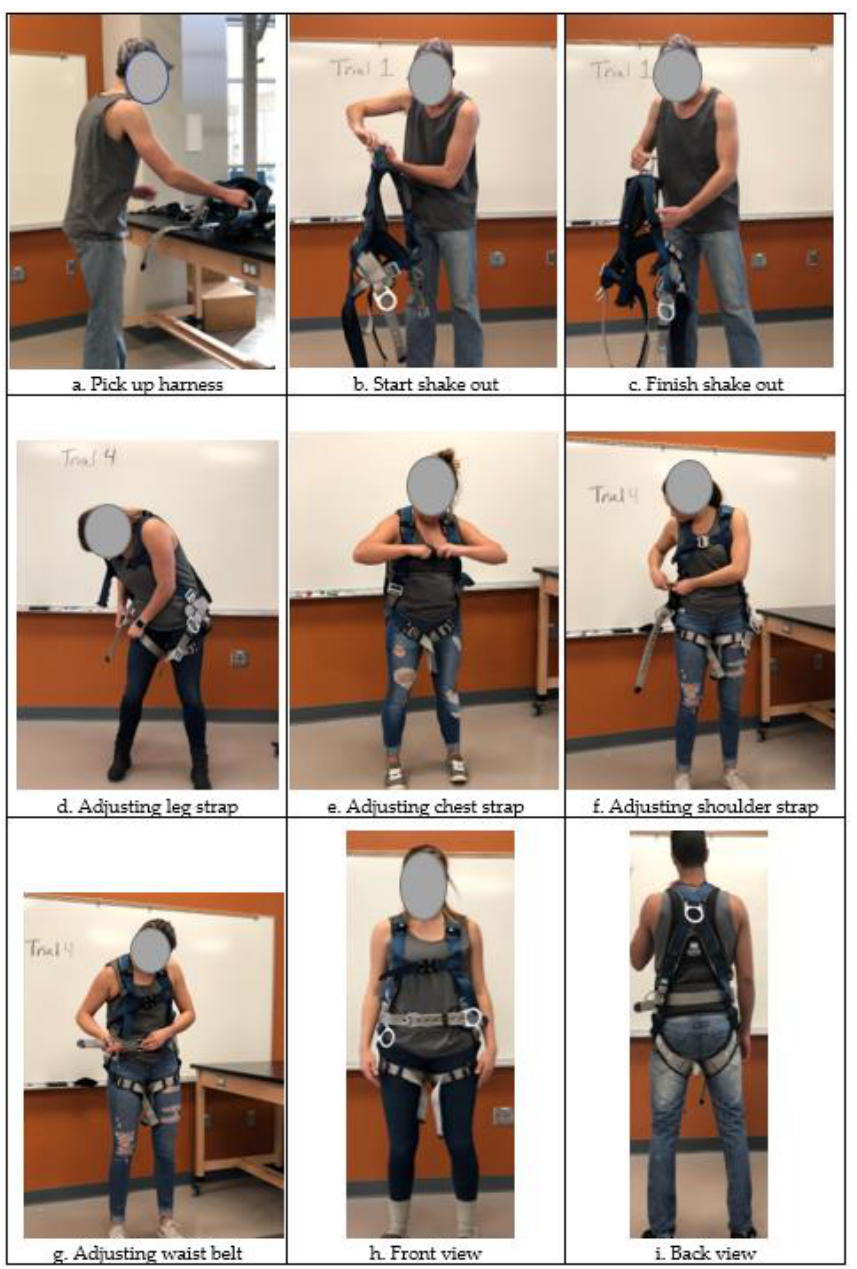
Figure 3. Examples of subjects performing steps during the study. Photos from Zachery Bunney’s thesis [28].